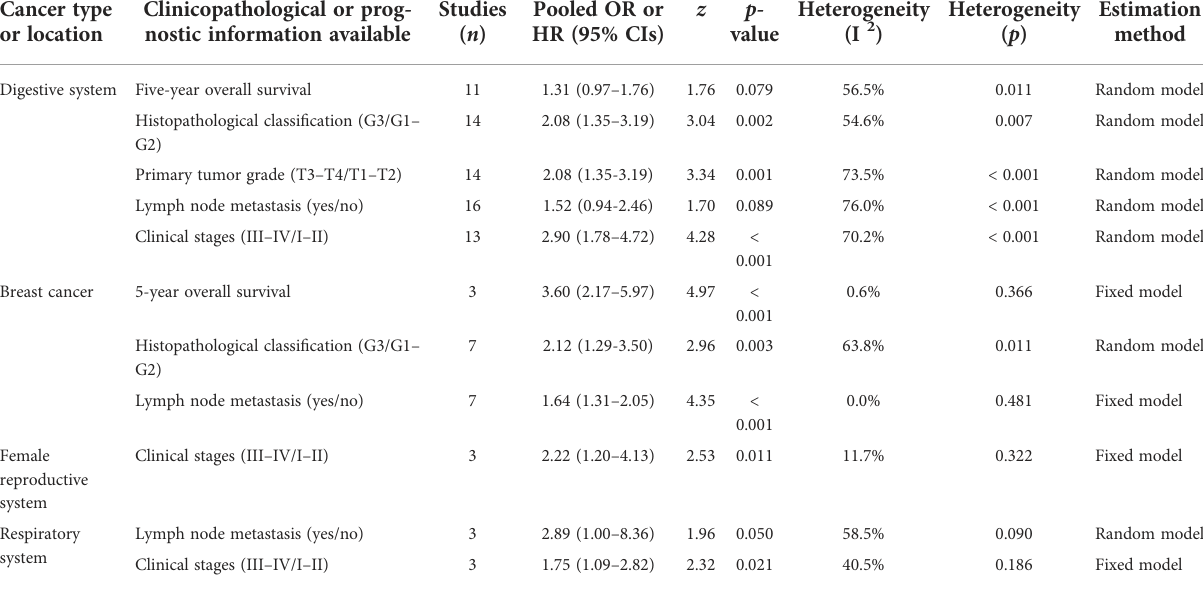
TABLE 3 The results for meta analysis between PLK-1 and cancers in different systems. Cancer type or